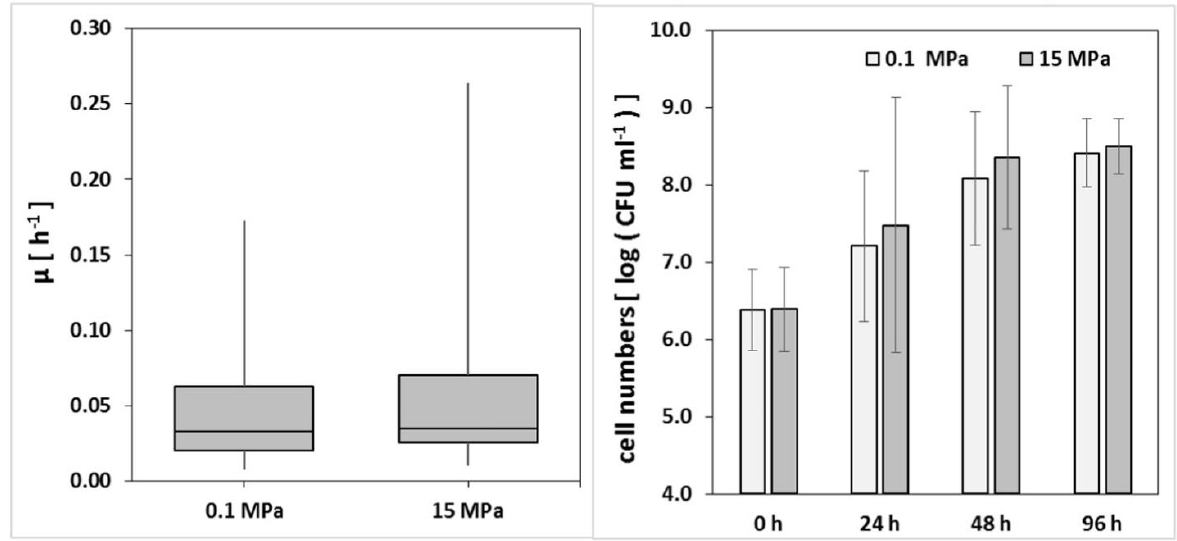
Figure 10. ( Left ): Boxplot of growth rates of all incubations of Rhodococcus sp. PC20 at 0.1 MPa and 15 MPa (22–192 h; n = 60 from 21 experiments). x -axis: amount of pressure in which the Rhodococcus sp. PC20 is exposed to; y -axis: average cell density of Rhodococcus sp. in atmospheric and elevated pressure ( Right ): Example of growth of Rhodococcus sp. PC20 at 0.1 and 15 MPa; 20 mL MM2 medium; 200 μL crude oil; 200 rpm; RT; in triplicates. 2 columns b/w. x -axis: incubation periods in hours; y -axis: Rhodococcus sp. PC20 cell densities on specific pressures. Adapted from Hackbusch et al. [131] .